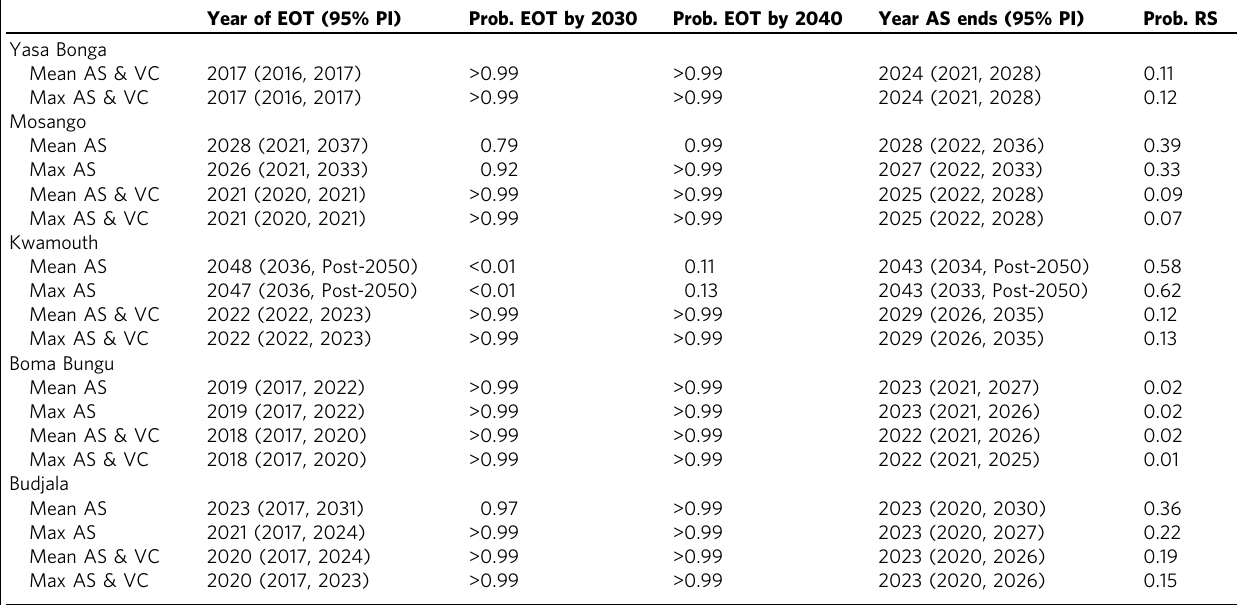
Table 2 Feasibility of elimination (additional scenarios are shown in the